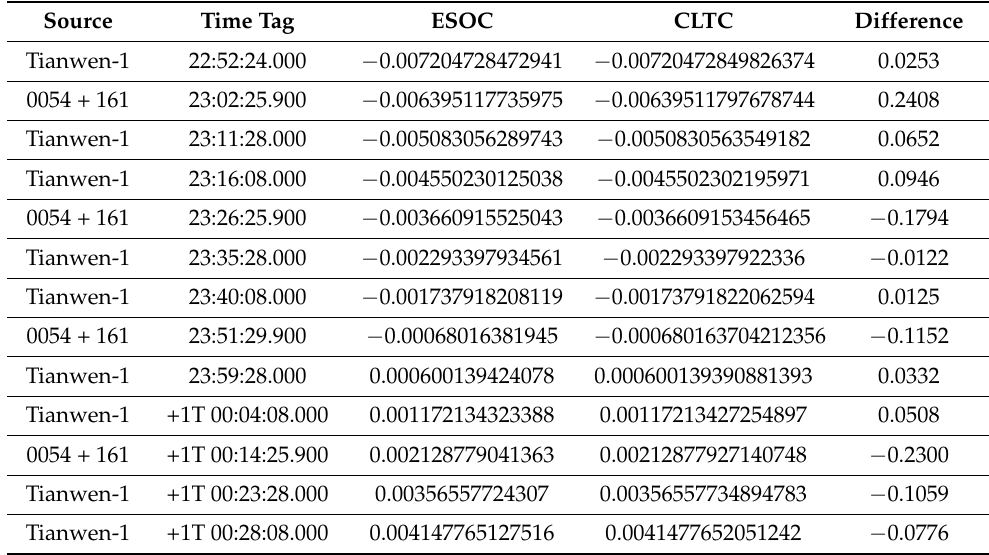
Table 5. Comparison of observables from CLTC and ESOC.